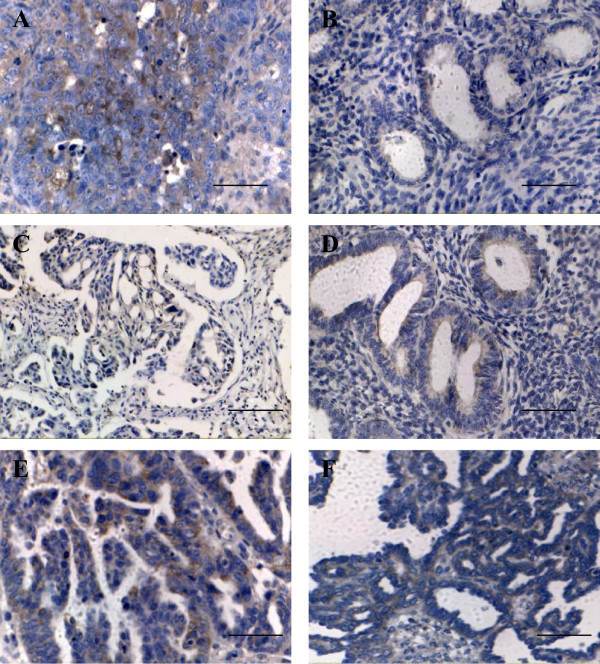
The immunohistochemical expression of claudin-6, occludin and MMP-2 in ovarian papillary serous carcinoma and ovarian serous adenoma. A, Claudin-6 was strongly expressed in ovarian carcinoma; B, Claudin-6 was weakly expressed in ovarian serous adenoma; C, Occludin expression in ovarian carcinoma; D, Occludin expression in ovarian serous adenoma; E, MMP-2 was strongly expressed in ovarian carcinoma; F, MMP-2 was weakly expressed in ovarian serous adenoma. [bar line = 50 μm].